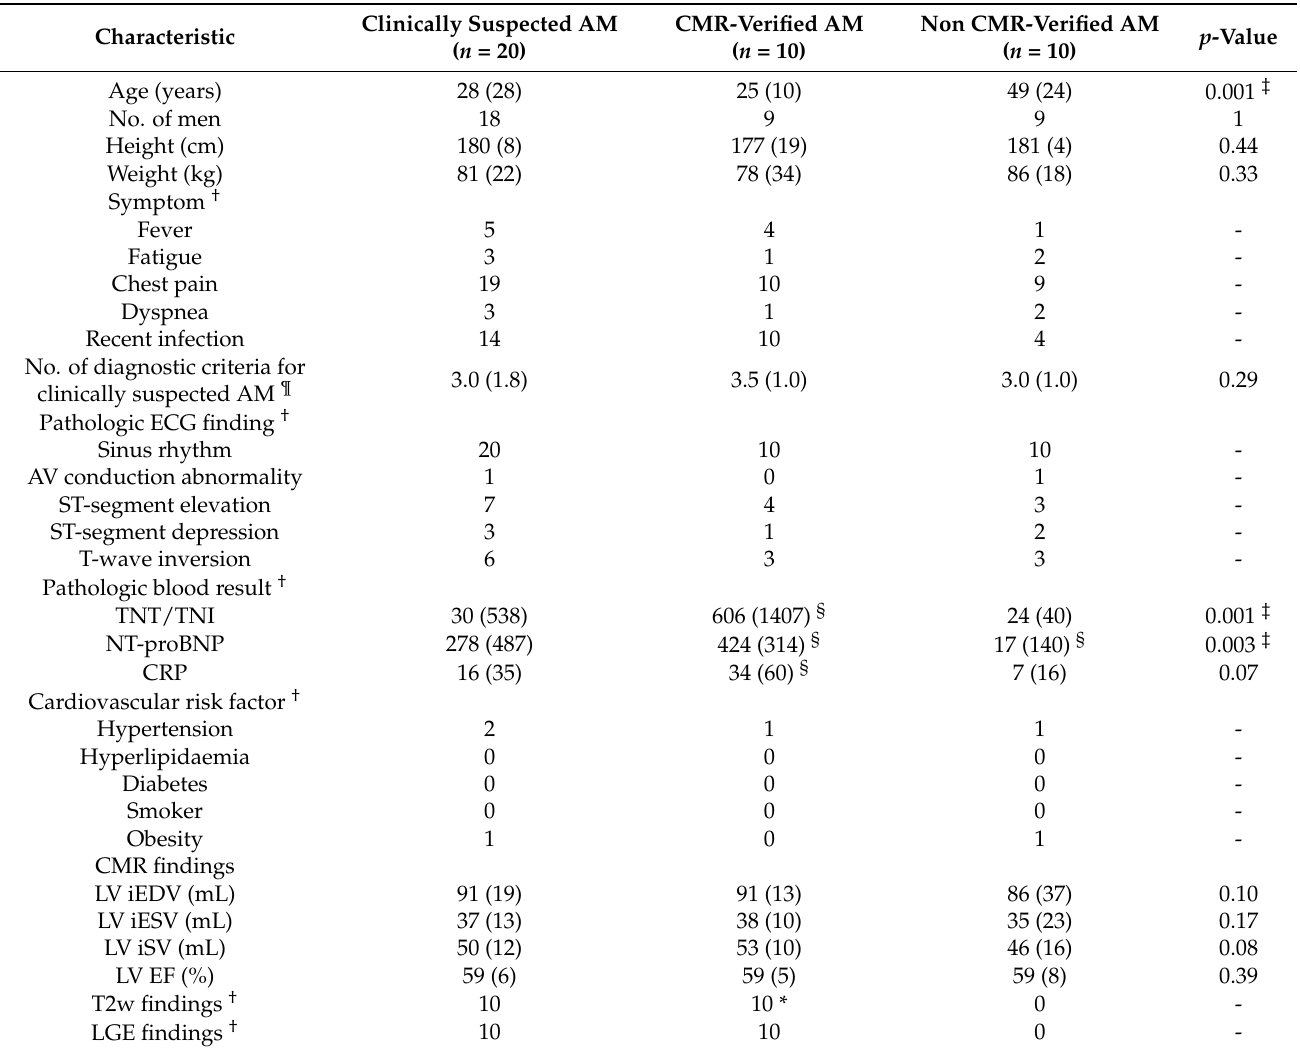
Table 1. Basic patient